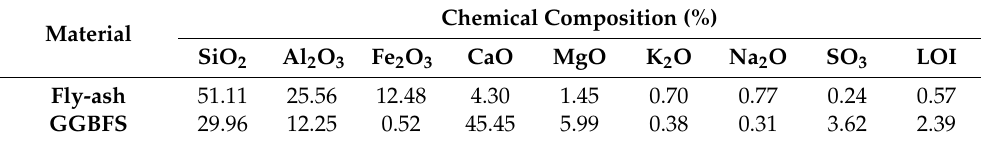
Figure 1. Particle size distribution of fly-ash and GGBFS. Table 2. Chemical compositions of materials used, as provided by suppliers.